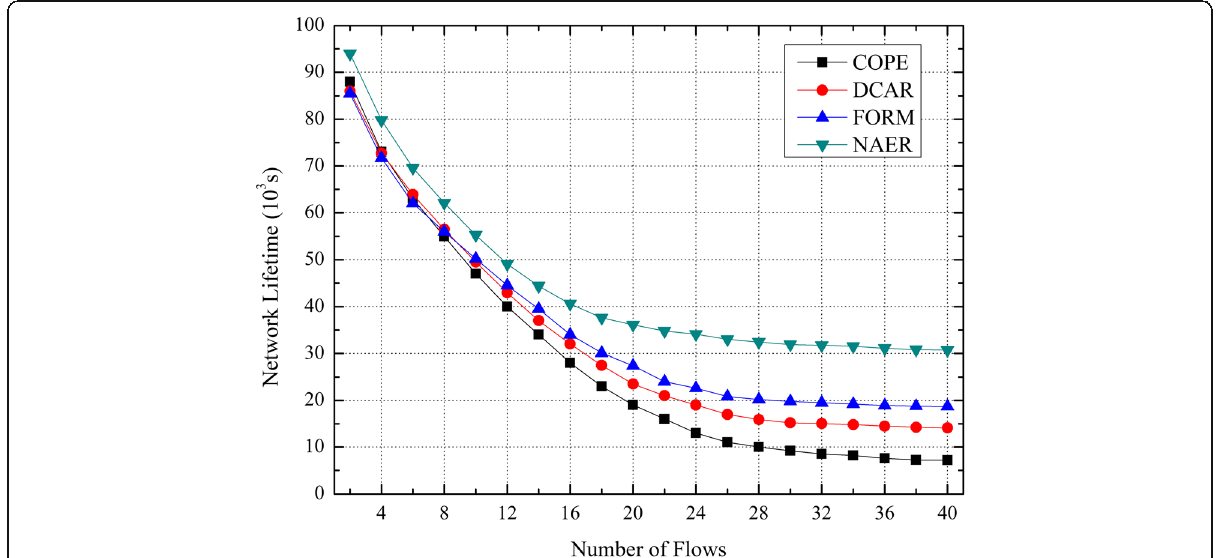
Fig. 28 Network lifetime under different number of flows in random network. Figure 28 shows the network lifetime comparison of COPE, DCAR, FORM, and NAER under different number of flows in random